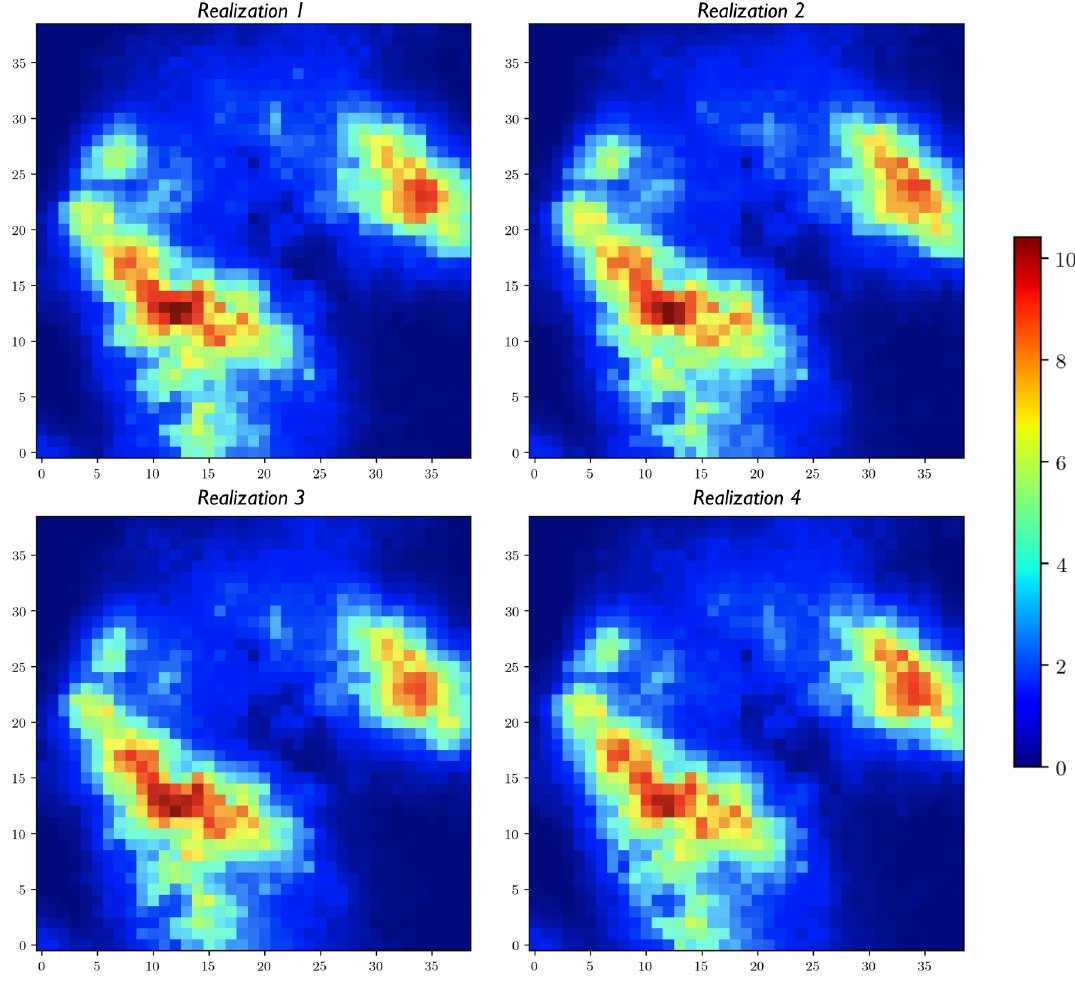
Figure 8. Stage 3 results: four randomly selected expected realizations (mm).